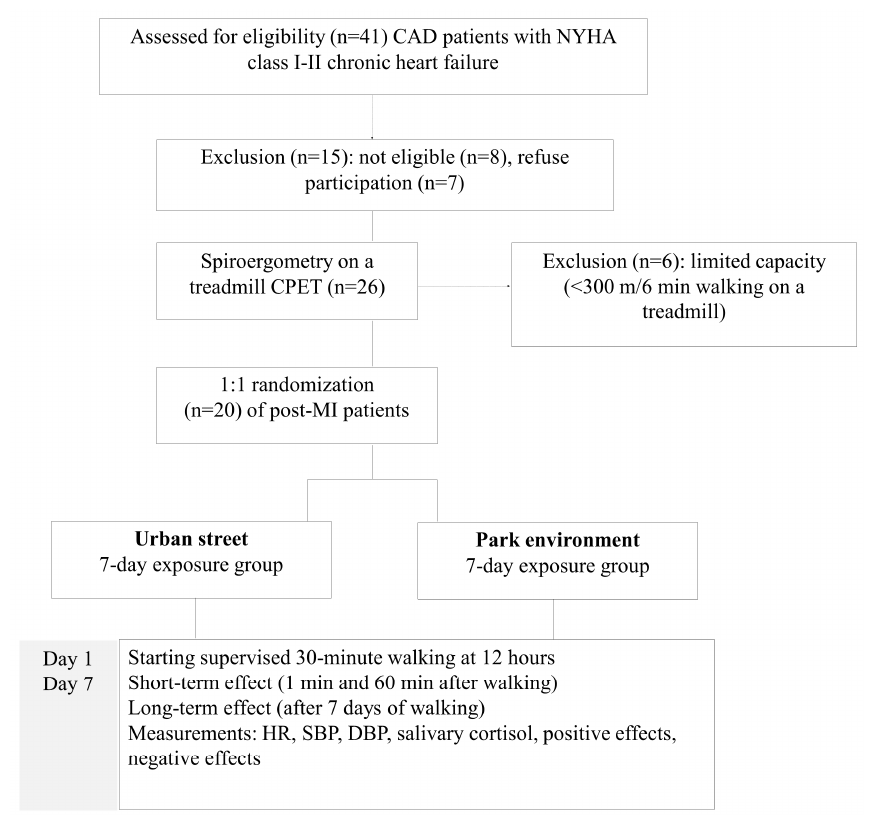
Figure 1. Randomization and investigation scheme of the urban street and the park environment exposure